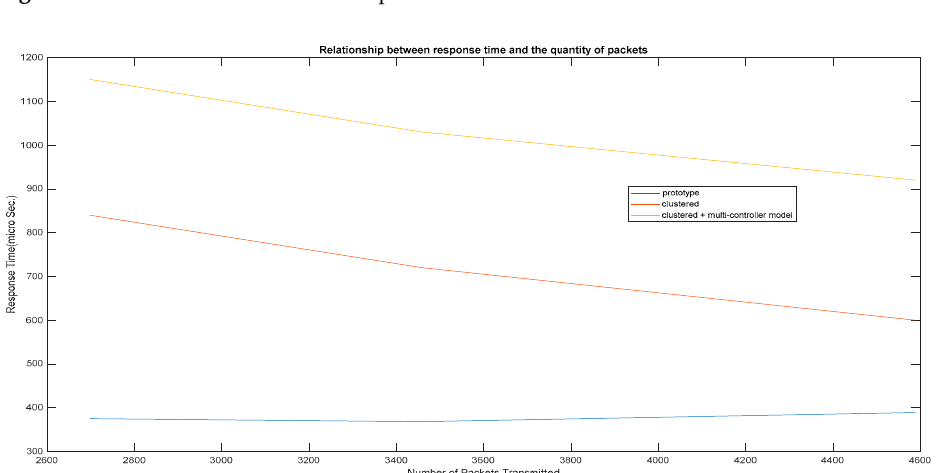
Figure 16. Path count in relation to response time.